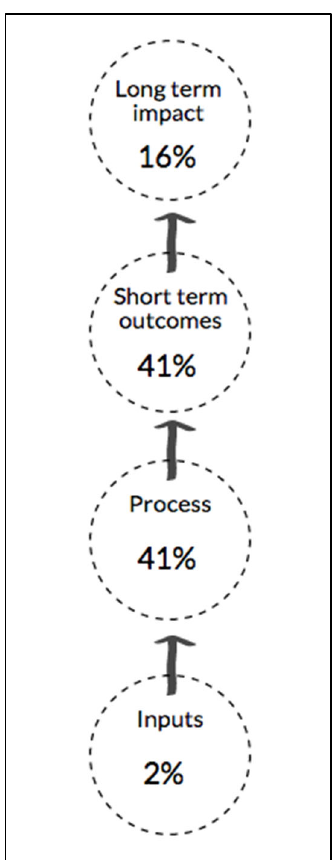
Figure 5. “Results